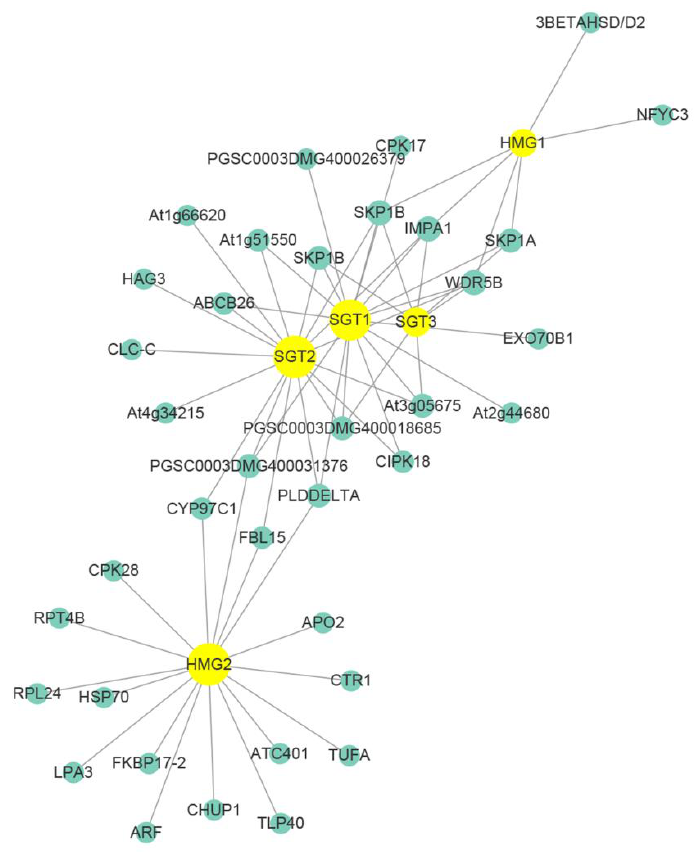
Figure 9. Co-expressional networks of genes responsible for SGA biosynthesis and disease resistance. In the photograph, the SGAs biosynthesis genes were marked in yellow, and the disease resistance genes were marked in green.